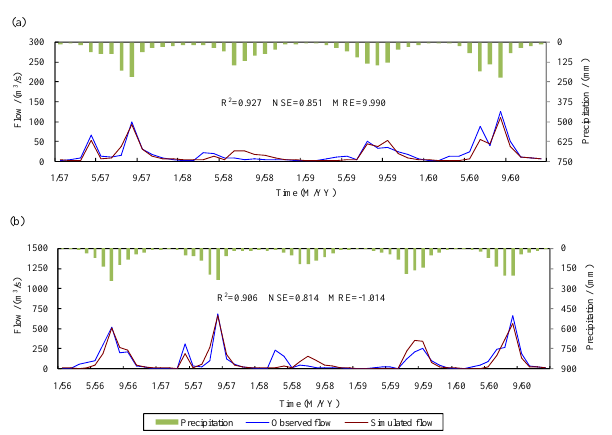
Fig. 6 Observed and simulated monthly streamflows during human interference parameter calibration period (1990–1995) at two discharge gauges: (a) Panshi and (b) Dongfeng. S0 refers to the consideration of human activities by the original SWAT2005 with calibrated physical parameters, while S1 refers to the consideration of human activities by the improved SWAT2005 with the calibrated physical and human interference parameters described above.